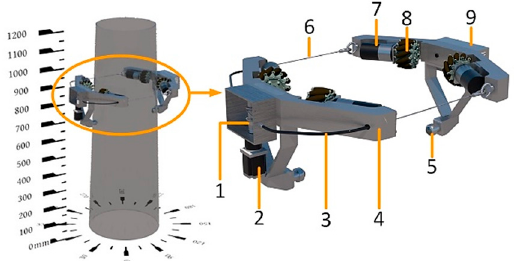
Figure 2. Wind Turbine Climbing Robot Model (1—Winding Mechanism with Twin Pulley, 2—Step Motor, 3—Bowden Cable, 4—Body Frame, 5—Caster Wheel, 6—Cable, 7—Motor, 8—Mecanum Wheel, 9—Electronic Casing-Embedded Microprocessor and Electronic module).